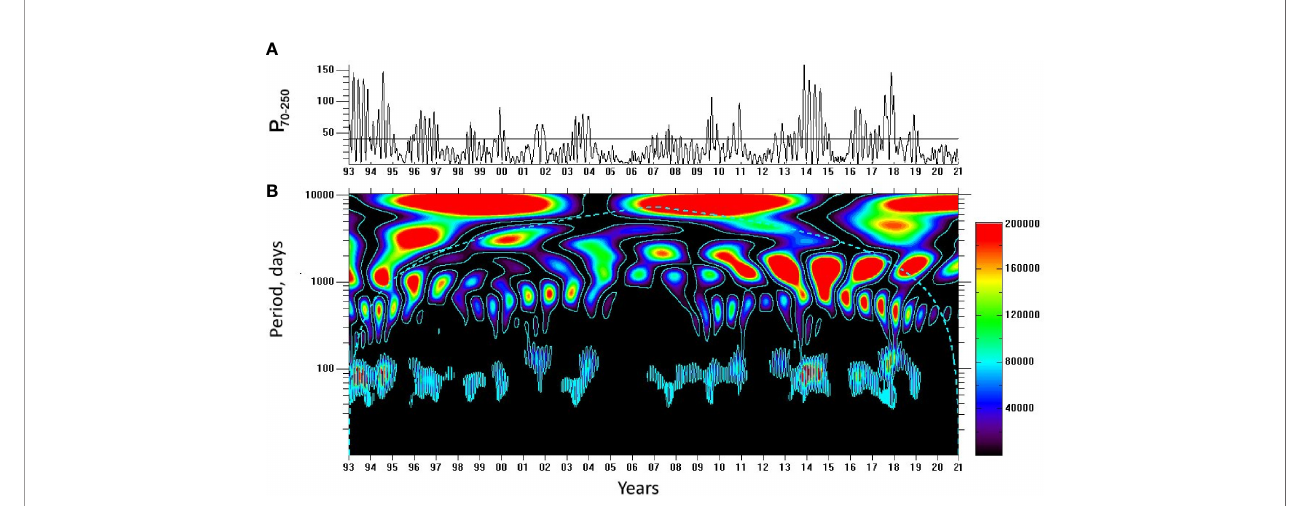
FIGURE 5 | (A) The band-averaged power of the PC HF 1 (dimensionless) and (B) its WT spectrum. In (A) the horizontal line corresponds to the sum of median and mean